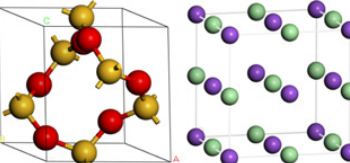
Figure 1. Structure of BeF 2 crystal (left)/ 7 LiF crystal (right).